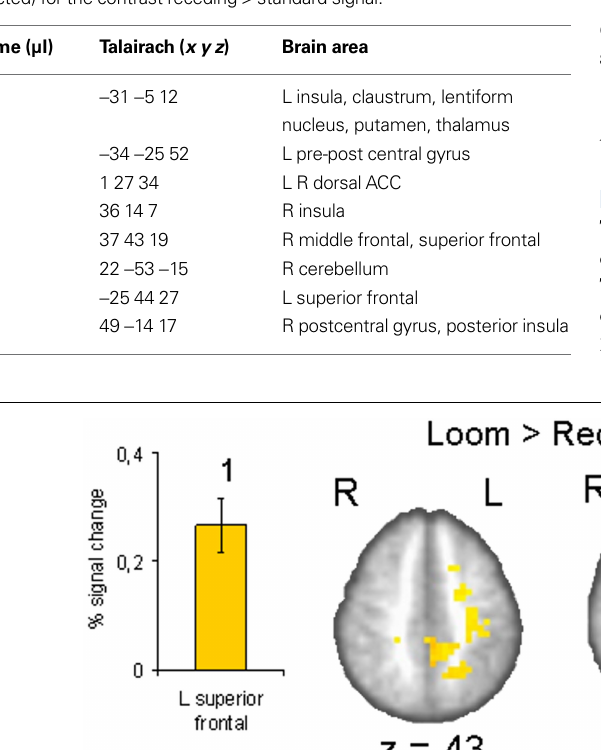
Table 3 | RECEDE > STANDARD. Regions of signifi cant activation ( P < 0.001, corrected) for the contrast receding > standard signal.